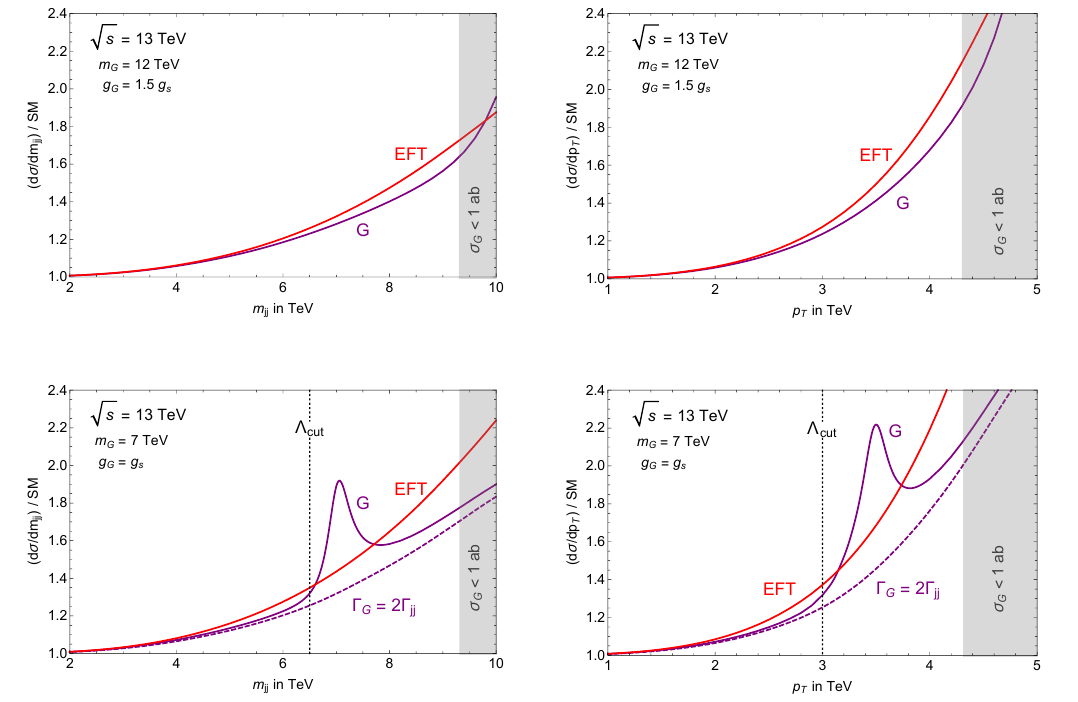
Figure 9 . Dijet (left panels) and inclusive jet (right panels) di(cid:11)erential cross sections normalized p to SM in the vector octet model for s = 13 TeV. Purple lines show the predictions for pp ! G ! jj from eq. (5.1), while red ones are calculated using the EFT, eq. (5.6). In the top row we show a heavy benchmark point, M = 12 TeV, in which G cannot be produced on-shell. The EFT is in very good agreement with the exact result all the way up to the point at which the cross section become negligibly small, as shown by the gray band. In the bottom row G is lighter, M = 7 TeV, and we show two possible widths (cid:0) = (cid:0) G and (cid:0) = 2(cid:0) G . In this case the EFT agrees with the UV completion, as long as the relevant energy variable is below (cid:3) cut , where (cid:3) cut = M (cid:0) (cid:0) G = 2 for